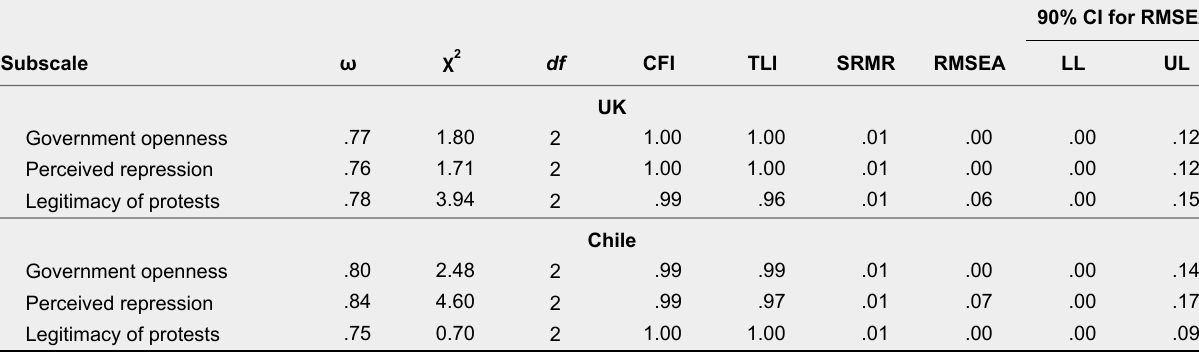
Internal Consistency Reliability Indices and Model Fit Statistics for Each Subscale by